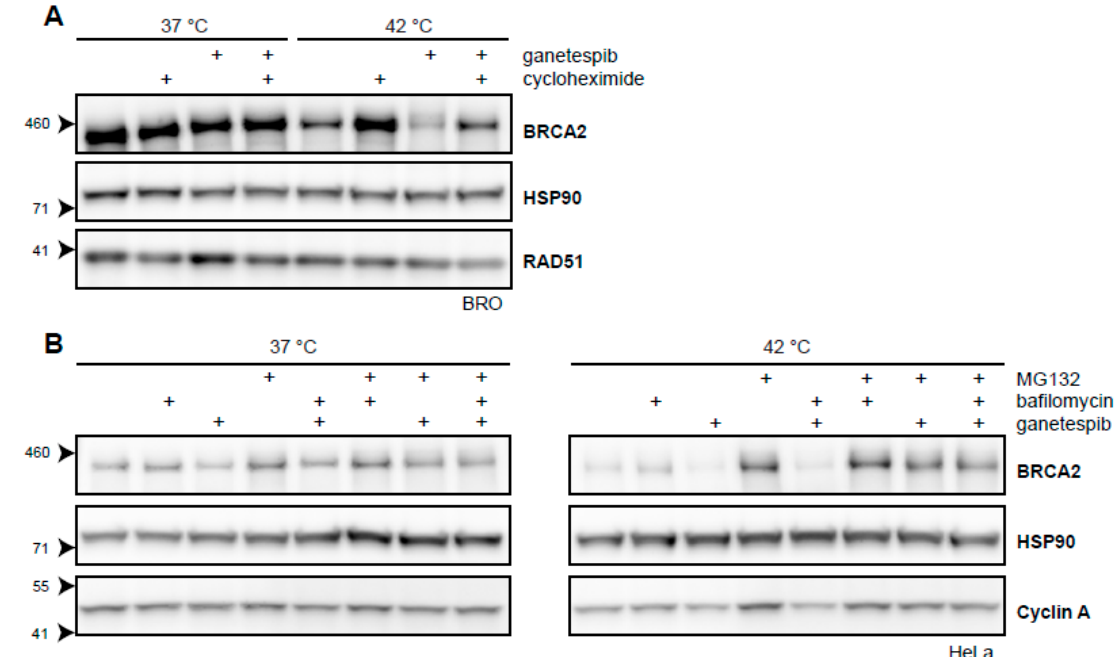
Figure 3. BRCA2 is a client protein of HSP90. ( A ) Immunoblot of BRO cells treated with or without 60 min of hyperthermia in the presence of cycloheximide (50 µg/mL), ganetespib (50 nM), or both. ( B ) Immunoblots of HeLa cells treated with or without hyperthermia in the presence of various combinations of proteasomal inhibitor MG132 (50 µM), autophagy inhibitor bafilomycin (10 nM), and HSP90-inhibitor ganetespib (50 nM).